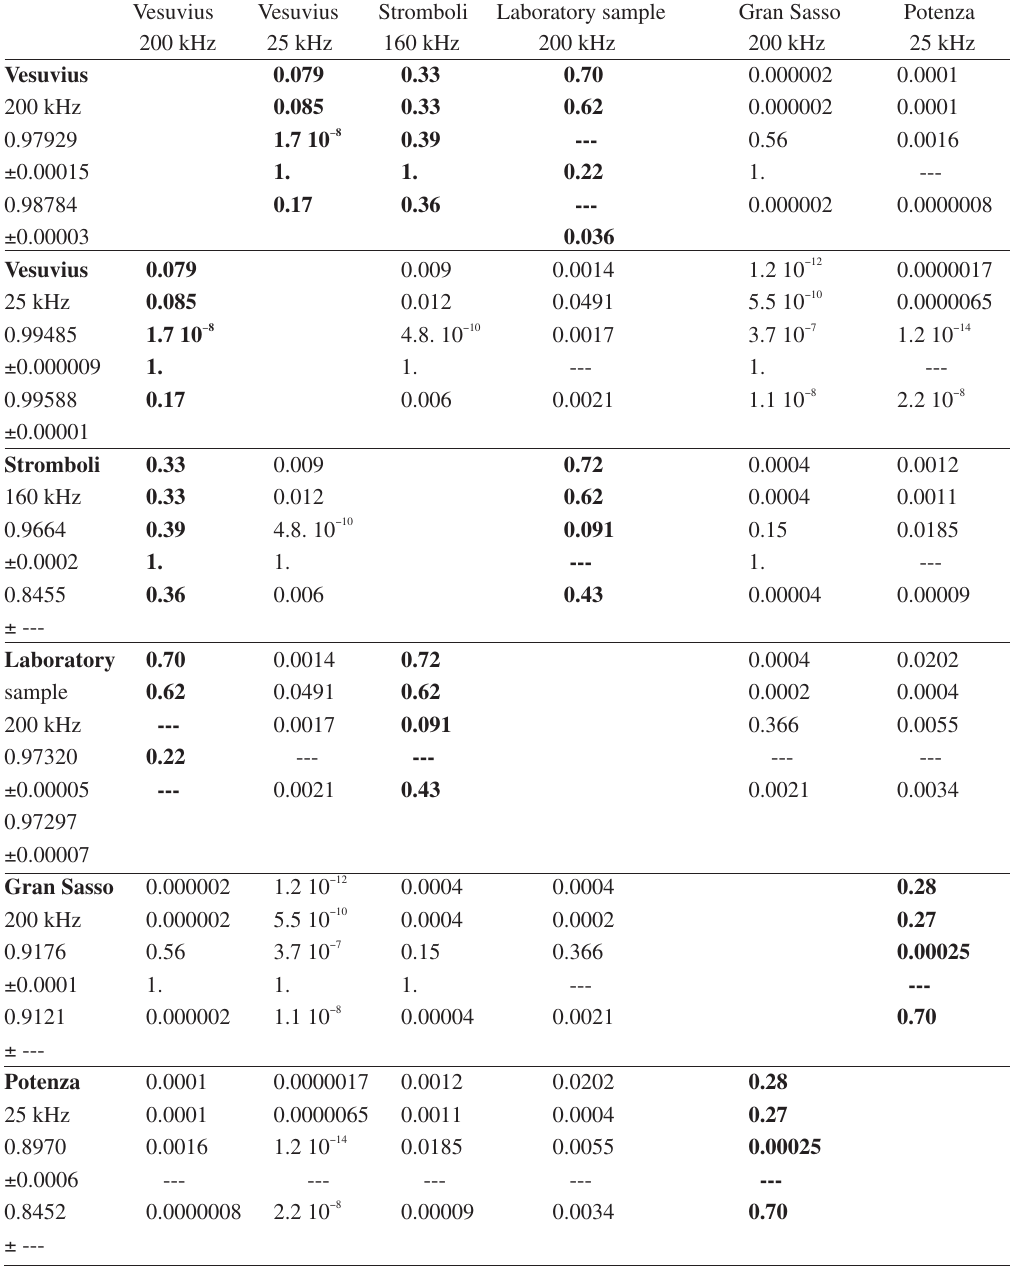
Table II. Similarity of the fractal dimensions D of the AE event sequences observed in different environments and case